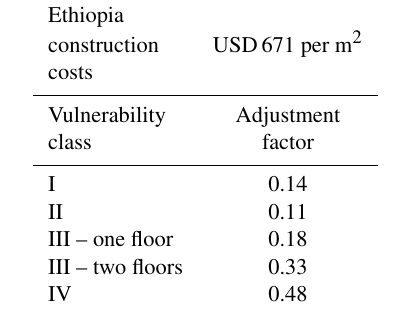
Table 4. Construction cost based on Huizinga et al. (2017) and ad- justment factors derived from the ImageCat data for Ethiopia.